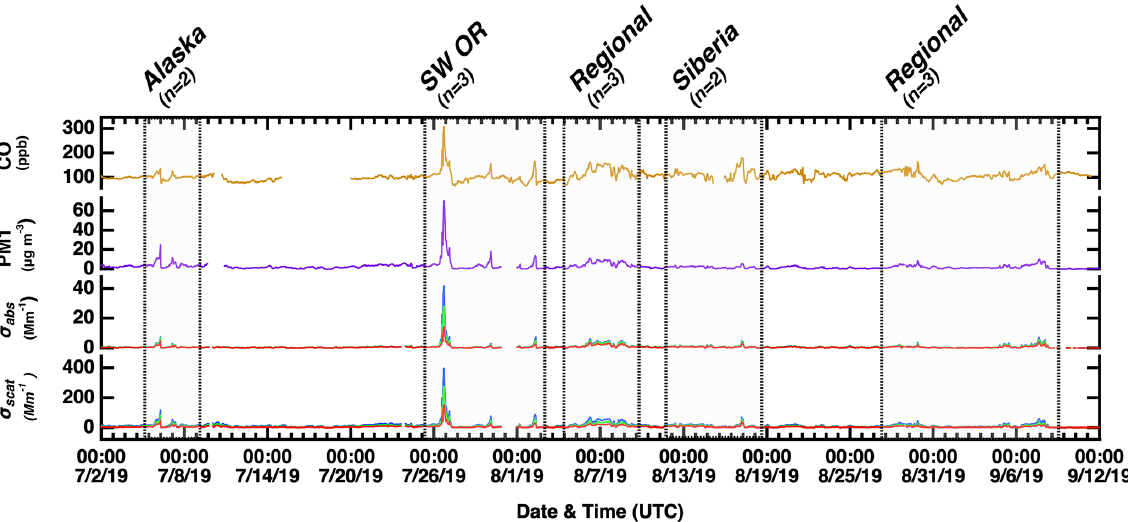
Figure 1. Time series (UTC) of the extensive properties CO (ppb), PM 1 (µgm − 3 ), scattering (Mm − 1 ), and absorption (Mm − 1 ) measured at MBO from 1 July to 14 September 2019. BB event periods are highlighted by grey-filled dashed boxes, with source identification and the number of discrete BB events with σ scat , green > 20Mm − 1 and CO > 110ppbv per period above. The blue, green and red lines in the σ abs and σ scat plots represent measurements in the blue, green and red channels,